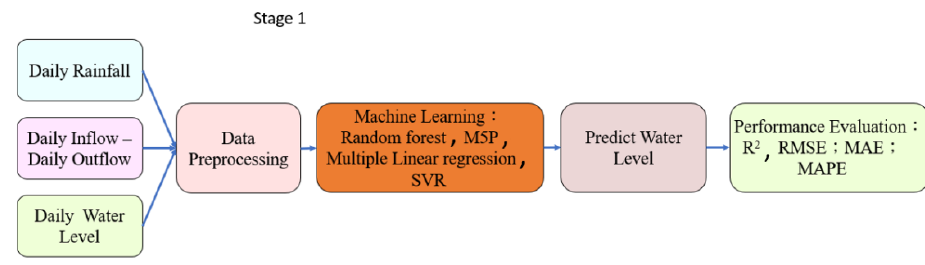
Figure 3. First stage of the proposed